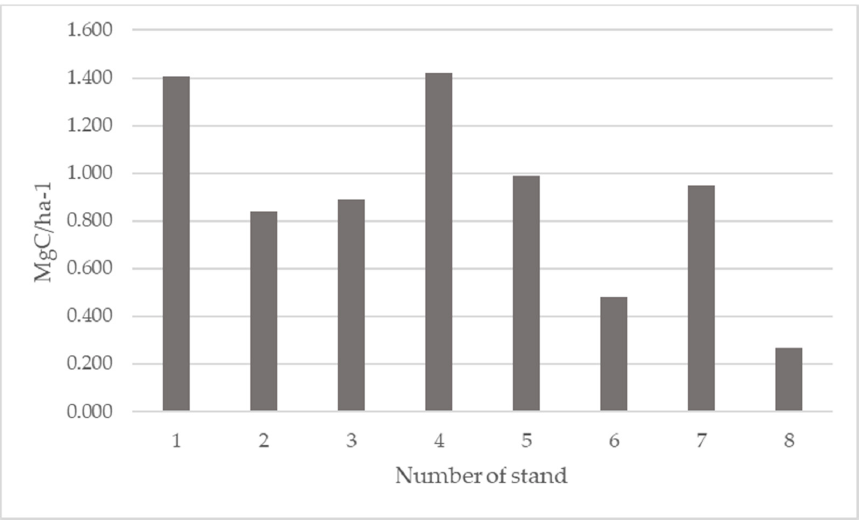
Figure 3. Annual carbon sequestration per hectare in megagrams.